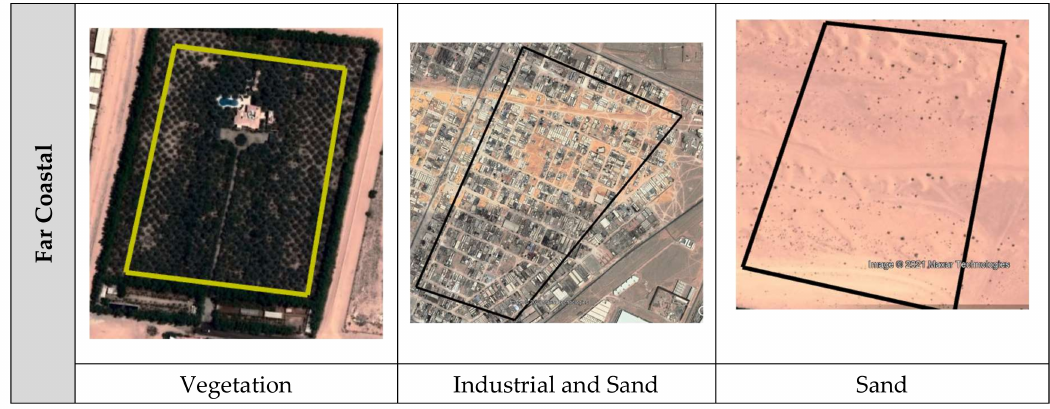
Figure 15. Sample of Close-range Images of Selected Analyzed Zones in Study Area.